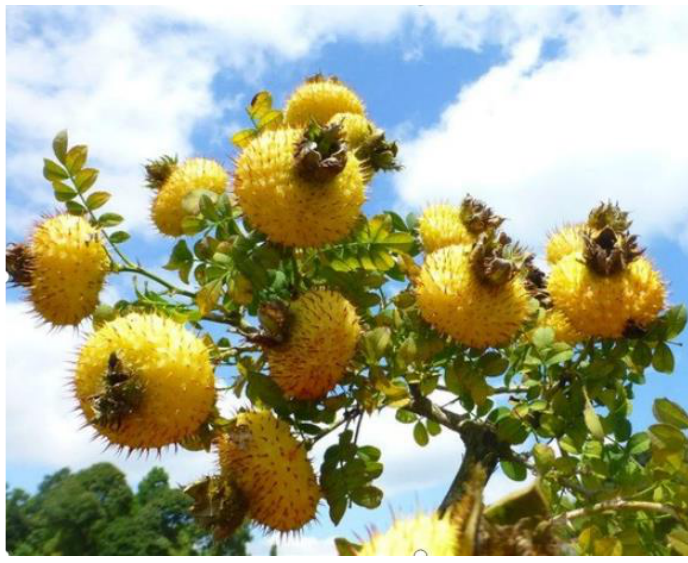
Figure 1. The plant of R. roxburghii.